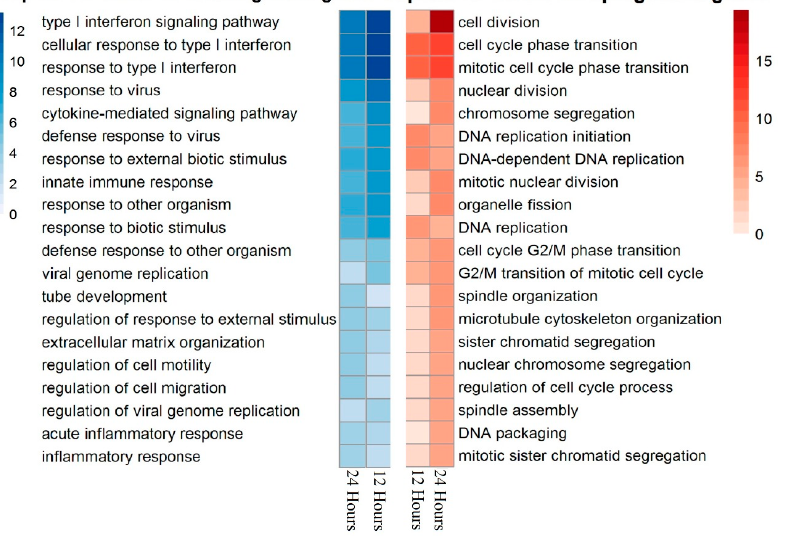
Figure 4. Biomarkers of senescence in PDGF ‐ BB ‐ treated MSCs. ( A ) Immunocytochemical evaluation of p21Waf1/Cip1 in control (CTRL) MSCs and after incubation with PDGF ‐ BB for 24 h. Fluorescent microscopy, green staining— p21Waf1/Cip1, blue staining—nuclei stained with DAPI. The percentage of p21+ cells did not significantly after PDGF ‐ BB C